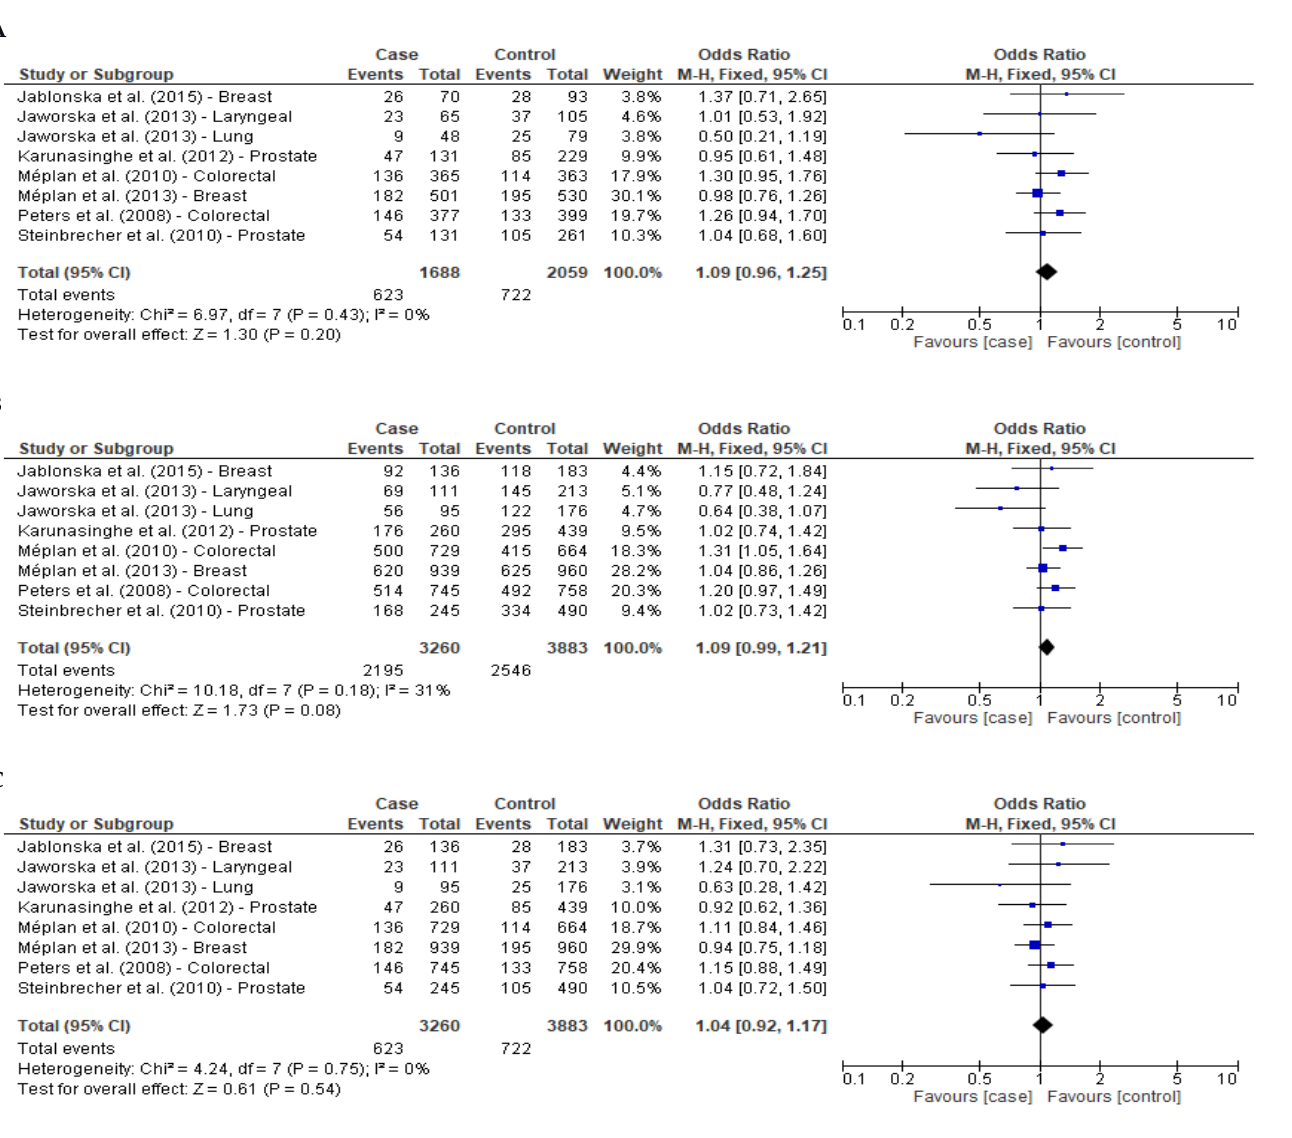
Figure 2. Forest plots of odds ratios with 95% confidence intervals of the association between GPX4 (rs713041) SNP and risk of cancer. ( A ) — Additive model (TT vs. CC) [16,17,19,20,35 – 37], ( B ) — Dominant model (CT+TT vs. CC) [16,17,19,20,35 – 37] and ( C ) — Recessive model (TT vs. CC+CT) [16,17,19,20,35 – 37].